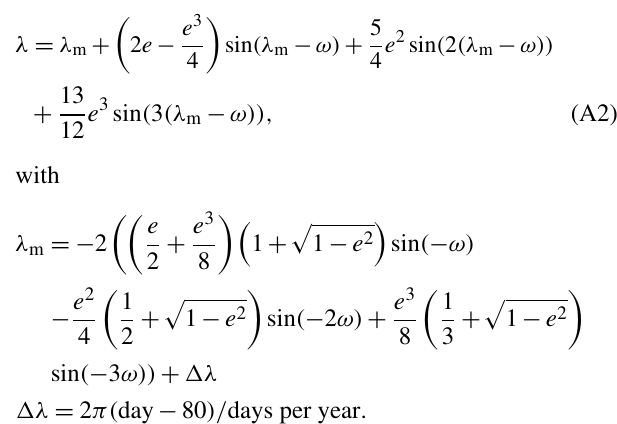
Fig. A3. A seasonality can be observed: the transmissivity is on average higher in June ( a = 0 . 61 and b = 0 . 026 km − 1 ) than in July ( a = 0 . 57 and b = 0 . 040 km − 1 ) and August ( a = 0 . 053 and b = 0 . 046 km − 1